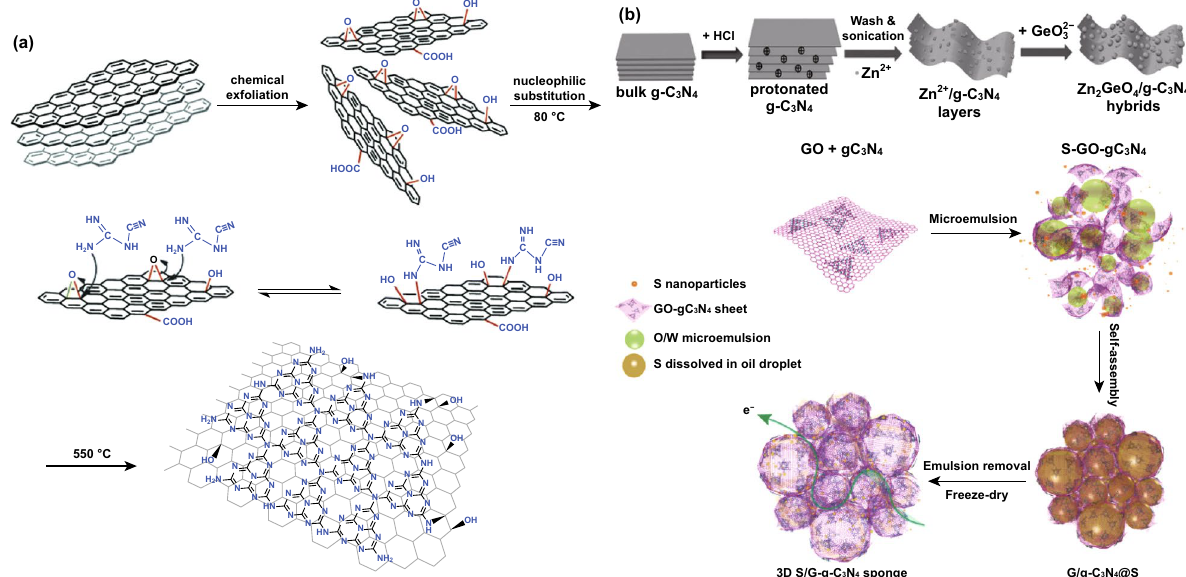
Fig. 16 a Illustration of the formation process of g-C 3 N 4 –rGO. Reproduced with permission from Ref. [110]. b Schematic of the synthesis process of the Zn 2 GeO 4 /g-C 3 N 4 hybrids. Reproduced with permission from Ref. [111]. c Schematic illustration of the procedure for preparing S/ GCN hybrid sponge. Reproduced with permission from Ref. [113]. Copyright permissions from Royal Society of Chemistry and Wiley–VCH. (Color figure